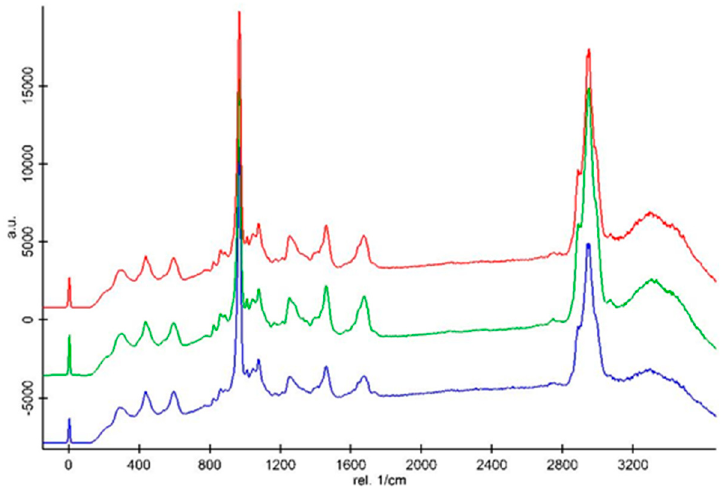
Figure 4. Representative Raman spectra of the dentin bridge of the MTA group (red line), the dentin bridge of the Biodentine™ group (blue line), and the primary dentin (green line).